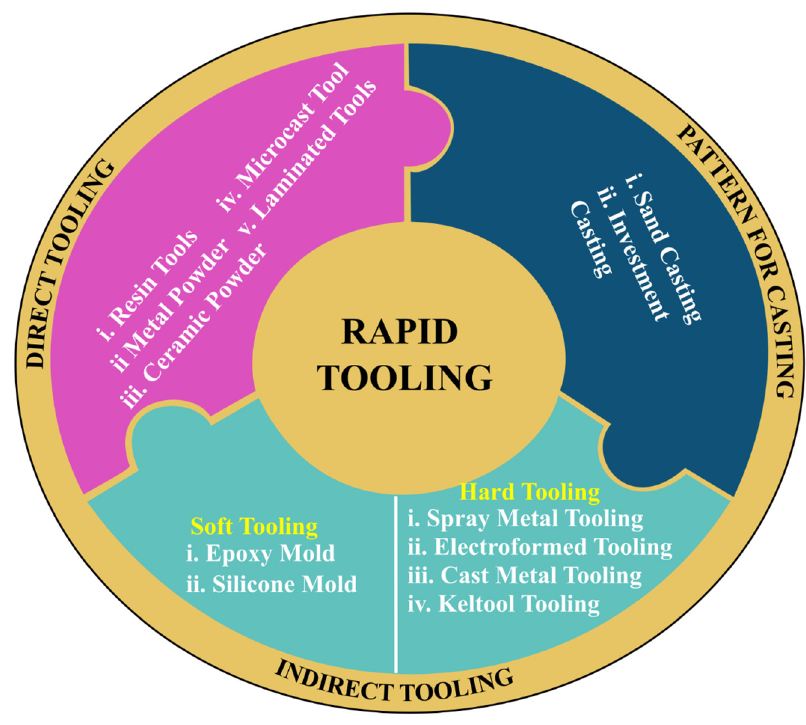
Figure 3. Classification of RT.